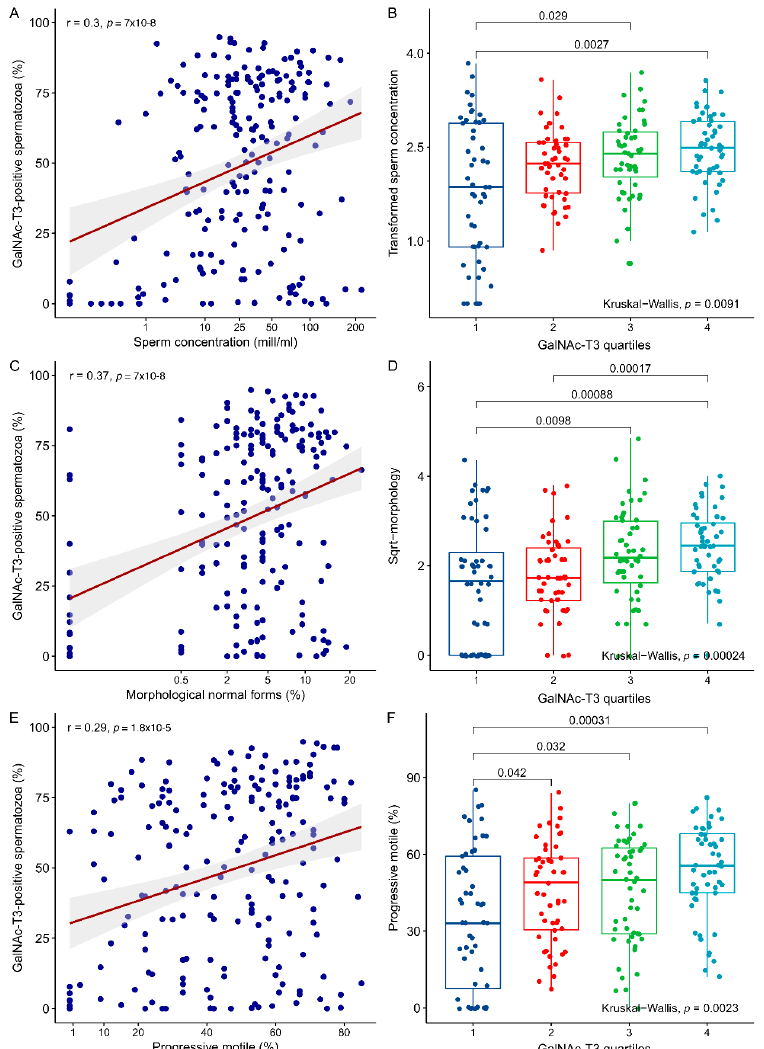
Figure 3. Association between the fraction of GalNAc-T3-positive spermatozoa in the ejaculate and classical semen parameters; sperm concentration, morphology and motility. Scatter plots of the fraction of GalNAc-T3-positive spermatozoa and ( A ) sperm concentration (4th-root transformed), ( C ) the fraction of spermatozoa with normal morphology (square root transformed), and ( E ) the fraction of progressive motile spermatozoa (un-transformed). In each scatter plot, the Pearson correlation quotient ( r ) is indicated together with the p -value of the association. The red line indicates the best linear fit and the grey shaded area the confidence interval. The fraction of GalNAc-T3-positive spermatozoa were divided into quartile-bins (1: Lowest and 4: Highest) and plotted against ( B ) sperm concentration (4th root-transformed), ( D ) the fraction of spermatozoa with normal morphology (square root (Sqrt) transformed), and ( F ) the fraction of progressive motile spermatozoa (un-transformed). p -values of individual comparisons (Wilcoxon rank sum tests) are indicated on each plot together with the overall significance of the grouping (Kruskal-Wallis test).